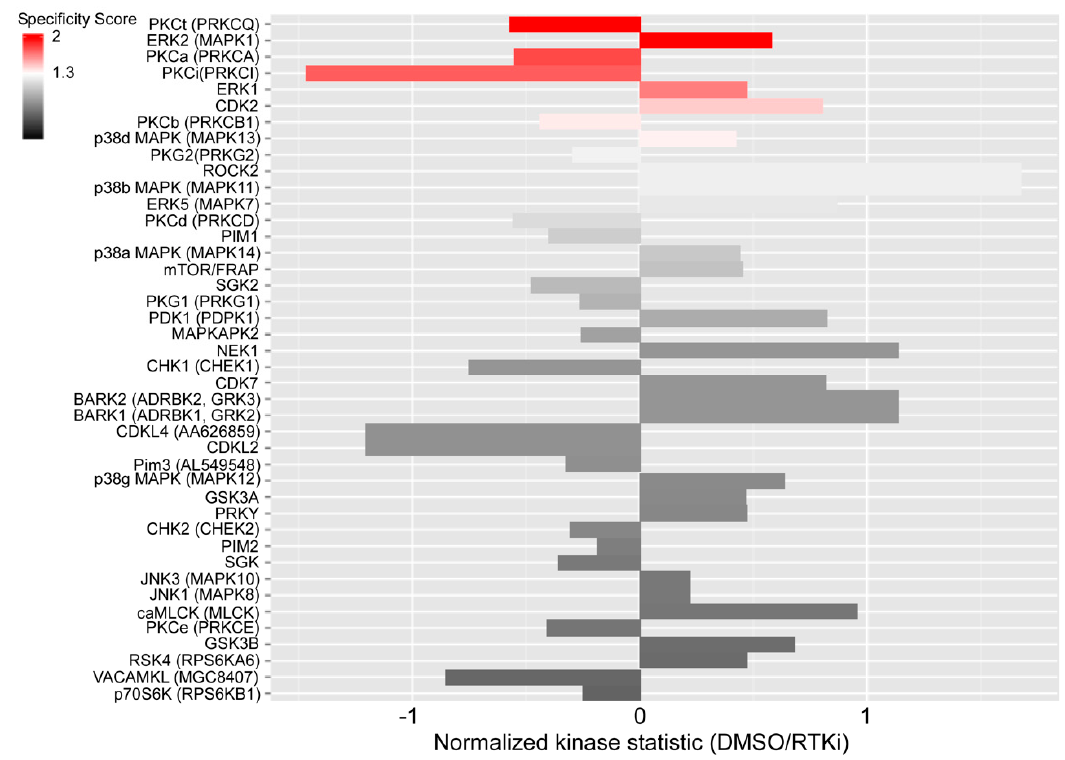
Figure 3. Regulation of serine/threonine signaling during tyrosine kinase inhibition. MOLM-13 cells were treated with DMSO or sorafenib for four hours before lysis. Lysates were applied to the Pamgene serine/threonine kinase profiling assays.